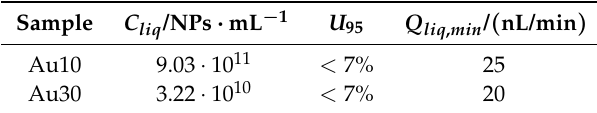
Table A10. Results of concentration measurements performed with electrospray-differential mobility analysis with a condensation particle counter